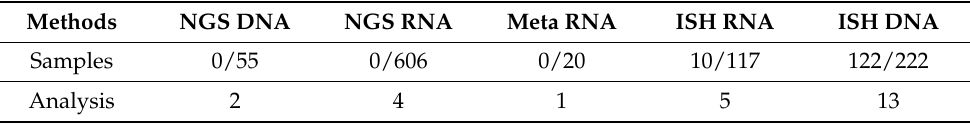
Table 7. Summarized results from 7 published studies for the detection of HCMV DNA and tran- scripts using NGS, metagenomic analysis, and ISH techniques.